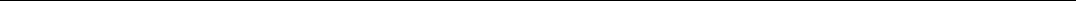
Fig. 5 Mirt2 inhibits TRAF6 oligomerization and auto-ubiquitination. a Silver-stained SDS-PAGE gel analysis of proteins in macrophages that are bound to biotinylated lncRNA-Mirt2. The highlighted regions were analyzed by mass spectrometry, identifying TRAF6 as a protein unique to Mirt2. b Immunoblotting analysis of proteins in macrophages bound to biotinylated Mirt2 using anti-TRAF6 antibody. c RNA immunoprecipitation (RIP) analysis to determine the recovery of Mirt2 in macrophages using anti-TRAF6 antibody. IgG served as control. Data represent the mean ± SEM of three independent experiments. * P < 0.05 vs. IgG group. d RNA FISH technology and immuno fl uorescent analysis to determine the co-localization of Mirt2 (green) and TRAF6 (red) in macrophages. DAPI was used for nucleus staining (blue). The images correspond to a single slice of Z-stacks and the experiments were repeated three times. e RNA pull-down analysis was employed to determine the interaction of TRAF6 with full-length or truncations of Mirt2. f Constructs for myc-tagged TRAF6 (wild type or domain truncation mutants) were transfected into HEK293T cells, pulled down by biotinylated Mirt2 transcript and examined by Western blot with antibody to myc. Bottom: the domain structure of TRAF6. g Immunoprecipitation of HA-TRAF6 (myc-TRAF6) followed by immunoblot analysis of myc-TRAF6 (HA-TRAF6) in HEK293T cells expressing both TRAF6 constructs to detect TRAF6 oligomerization in the presence or absence of Mirt2. h Immunoblot analysis of the ubiquitination of TRAF6 in HEK293T cells transfected to express myc-tagged TRAF6 and HA-tagged ubiquitin. Left panel: Total ubiquitination of TRAF6; Middle panel: K48-linked and K63-linked ubiquitination of TRAF6; Right panel: The effects of different concentrations of Mirt2 on the ubiquitination of TRAF6. i Immunoblot analysis of the K63-linked ubiquitination of endogenous TRAF6 in macrophages. j Immunoprecipitation of HA-Ubc13 (myc-TRAF6) followed by immunoblot analysis of myc-TRAF6 (HA-Ubc13) in HEK293T cells expressing both constructs to detect the interaction of TRAF6 and Ubc13. k Immunoblot analysis of the content of Ubc13 immunoprecipitated using TRAF6 antibody in macrophages. l Effects of Mirt2 knockdown on the phosphorylation of p65 and Jnk in macrophages transfected with si-TRAF6 or scramble siRNA,